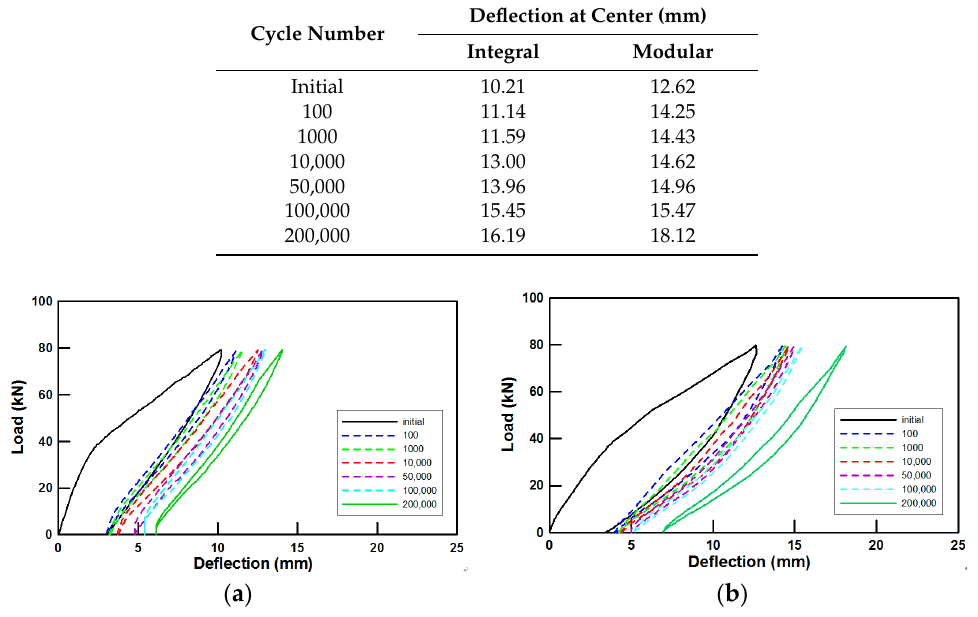
Figure 5. Load and deflection curves: ( a ) integral specimen; ( b ) modular specimen.